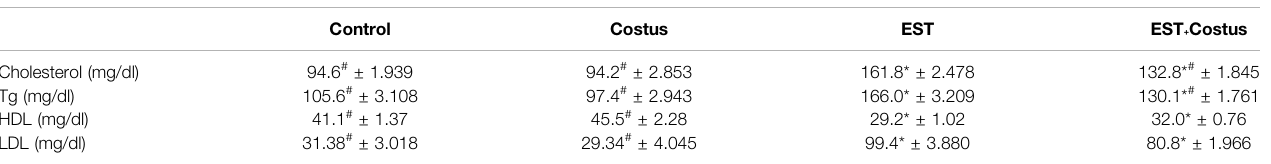
TABLE 3 | Effect of costus treatments on lipid pro fi les in the different groups studied.